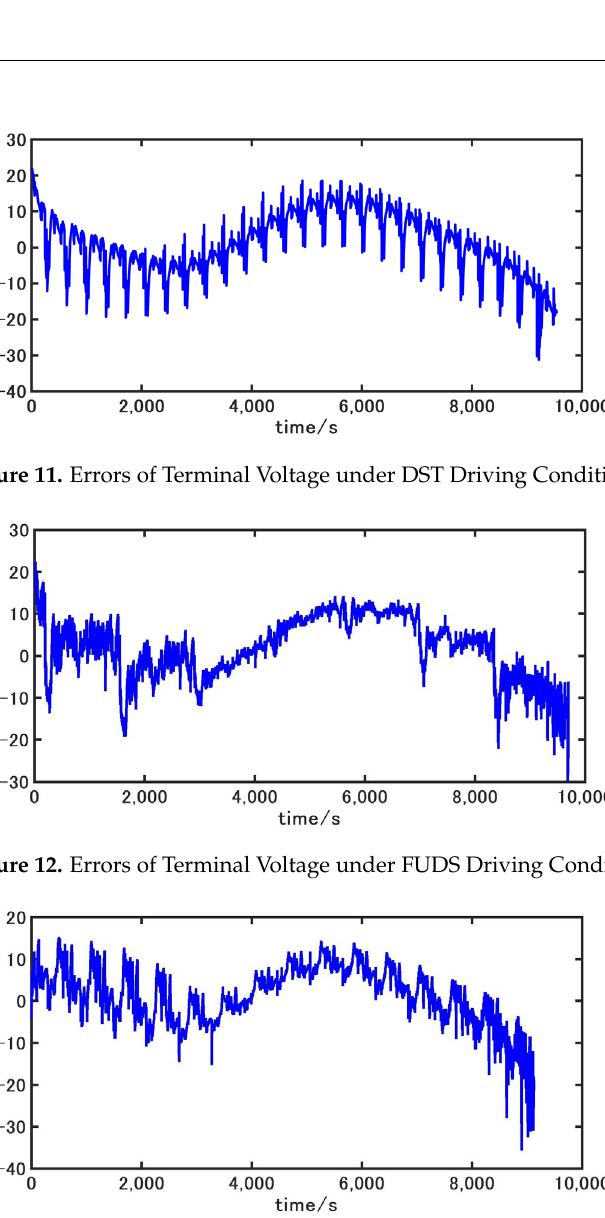
Figure 13. Errors of Terminal Voltage under US06 Driving Condition.